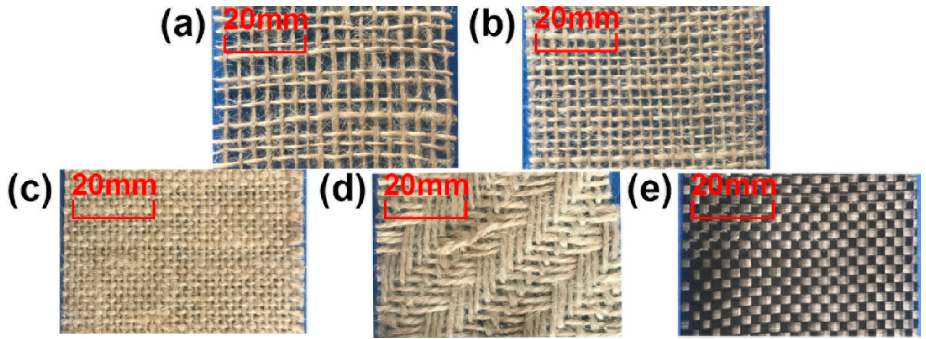
three-line twill jute fiber cloth, ( e ) carbon fiber cloth.